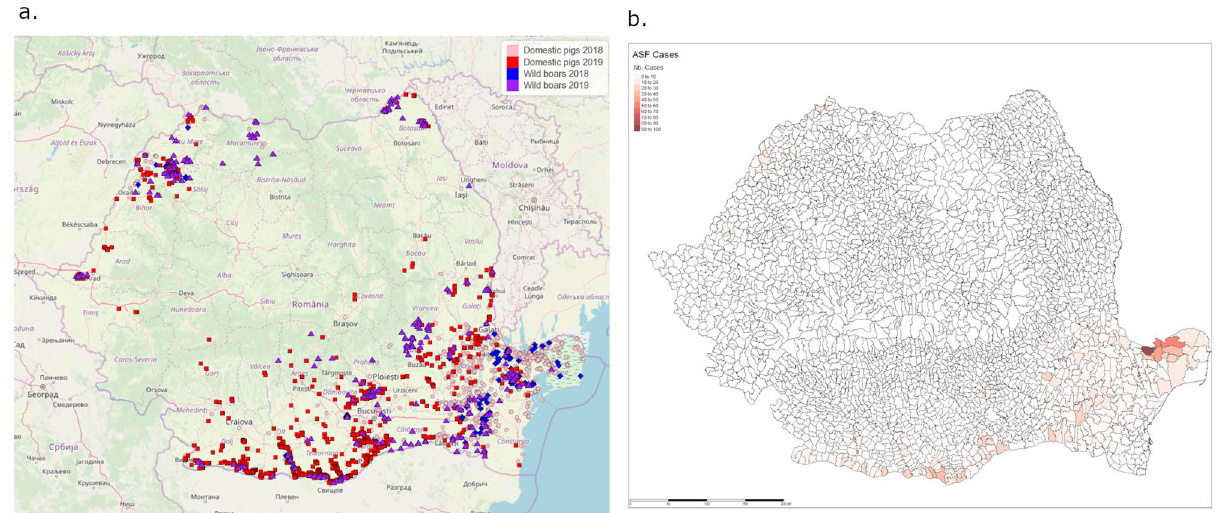
Figure 4. Spatial expansion of the ASF epidemics in Romania from June 10, 2018 to August 29, 2019; ( a ) case locations (map created using R 17 (version 4.0.2), packages tmap 18 and rgdal 19 ), ( b ) number of domestic pig outbreaks per